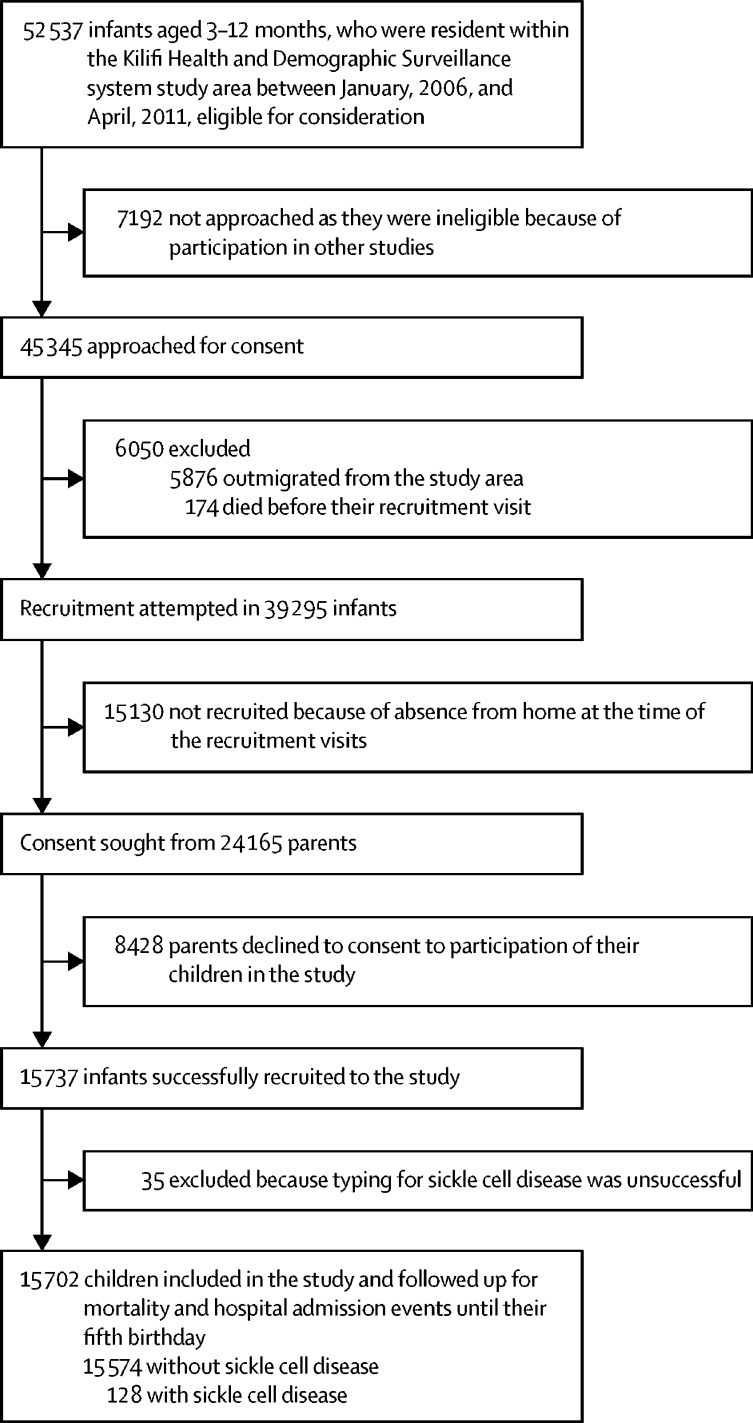
Cohort recruitment and follow-up